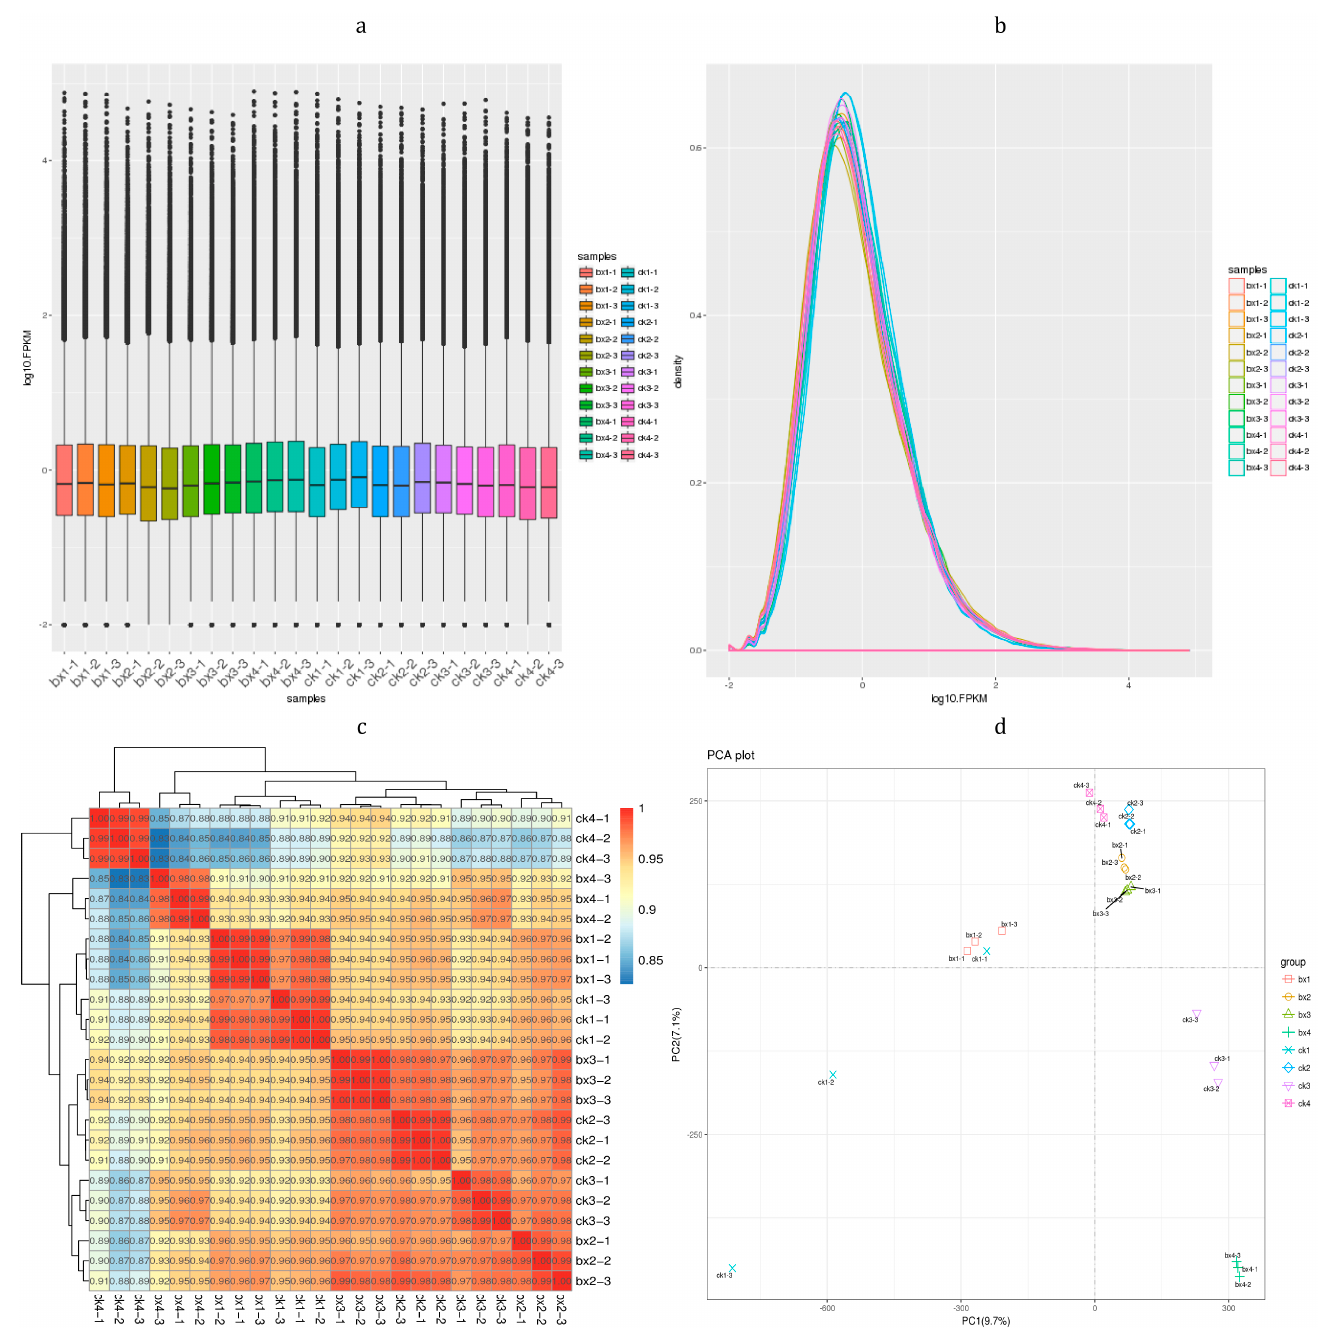
Figure 3. Gene expression analysis. ( a ) Box fi gure of FPKM. Horizontal is sample ID and ordinate is log 10FPKM ; ( b ) FPKM density distribution. Horizontal is log 10FPKM and ordinate is density; ( c ) Pearson correlation between samples; ( d ) Principal component analysis.